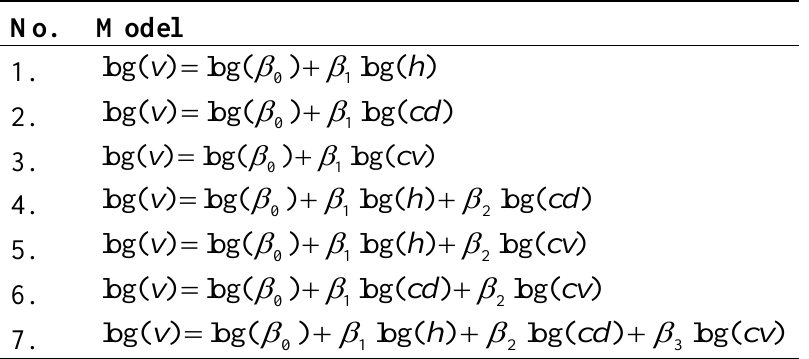
Table 7. Allometric models for stem volume